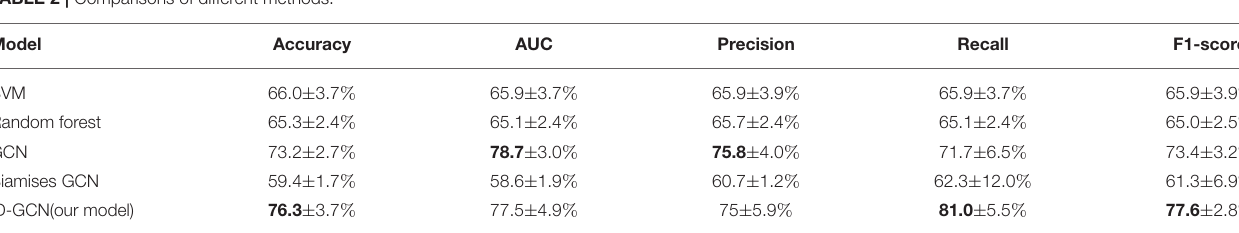
TABLE 2 | Comparisons of different methods.